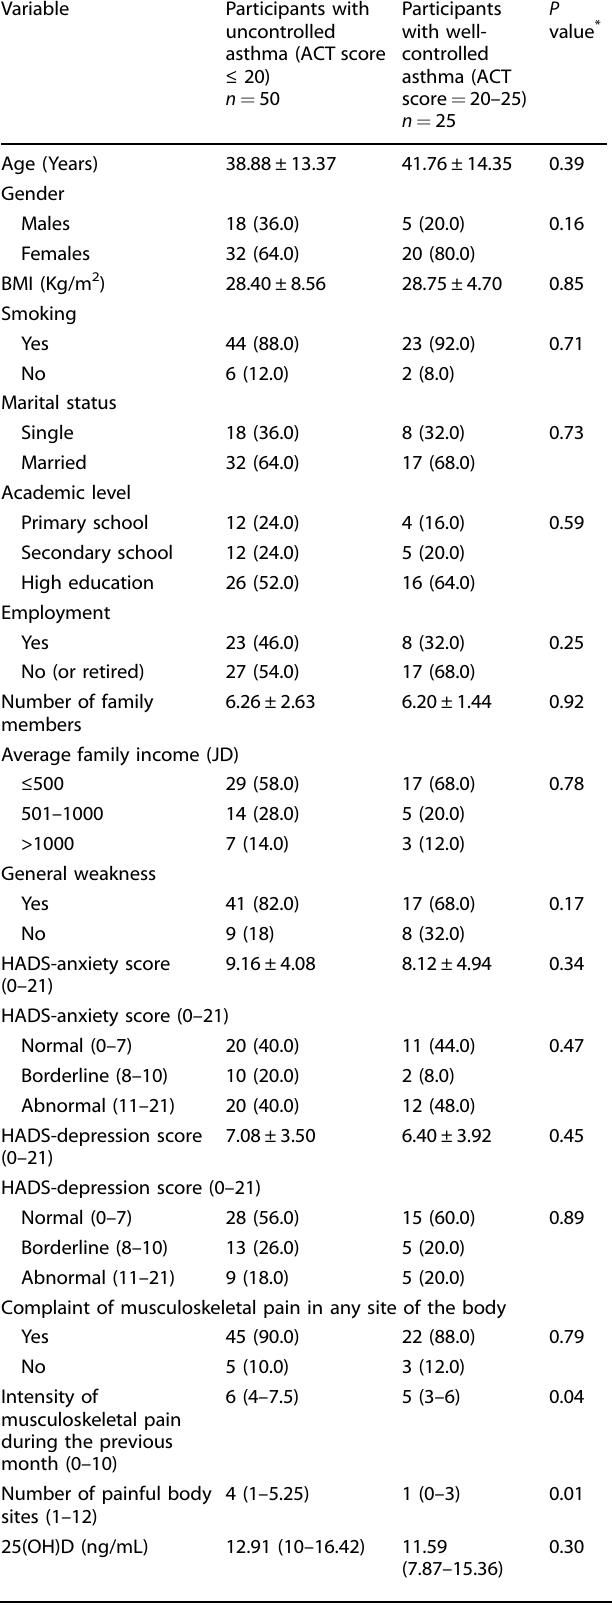
Table 3. Differences in study variables between participants with uncontrolled and well-controlled